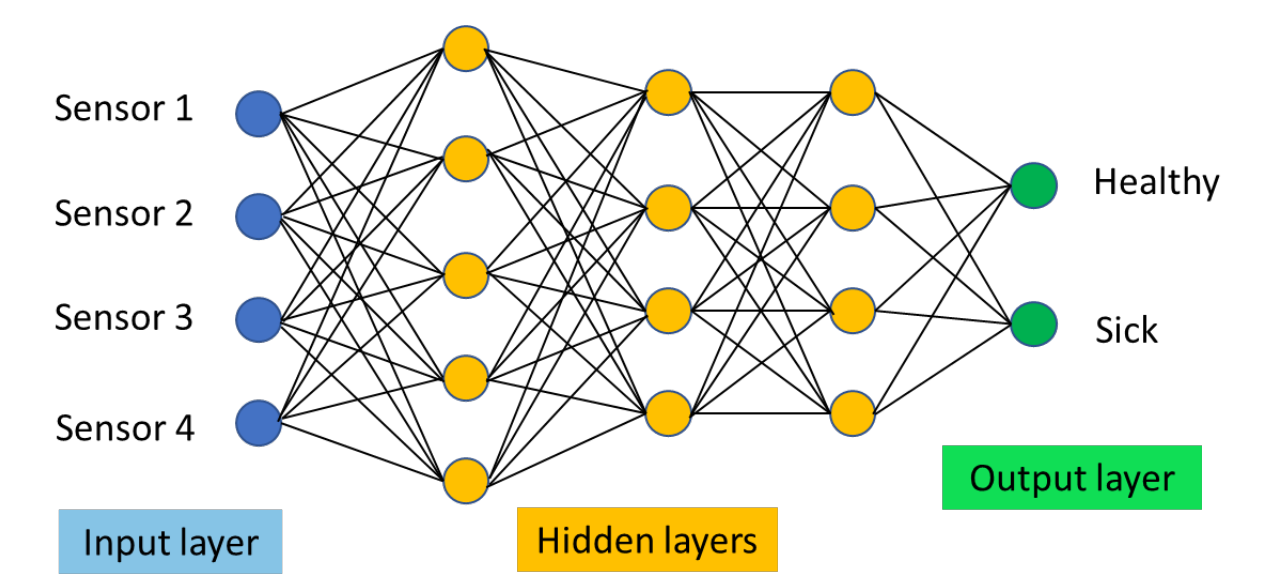
Figure 6. Simplified scheme of an ANN system architecture. In this example the e-nose is composed with 4 sensors.